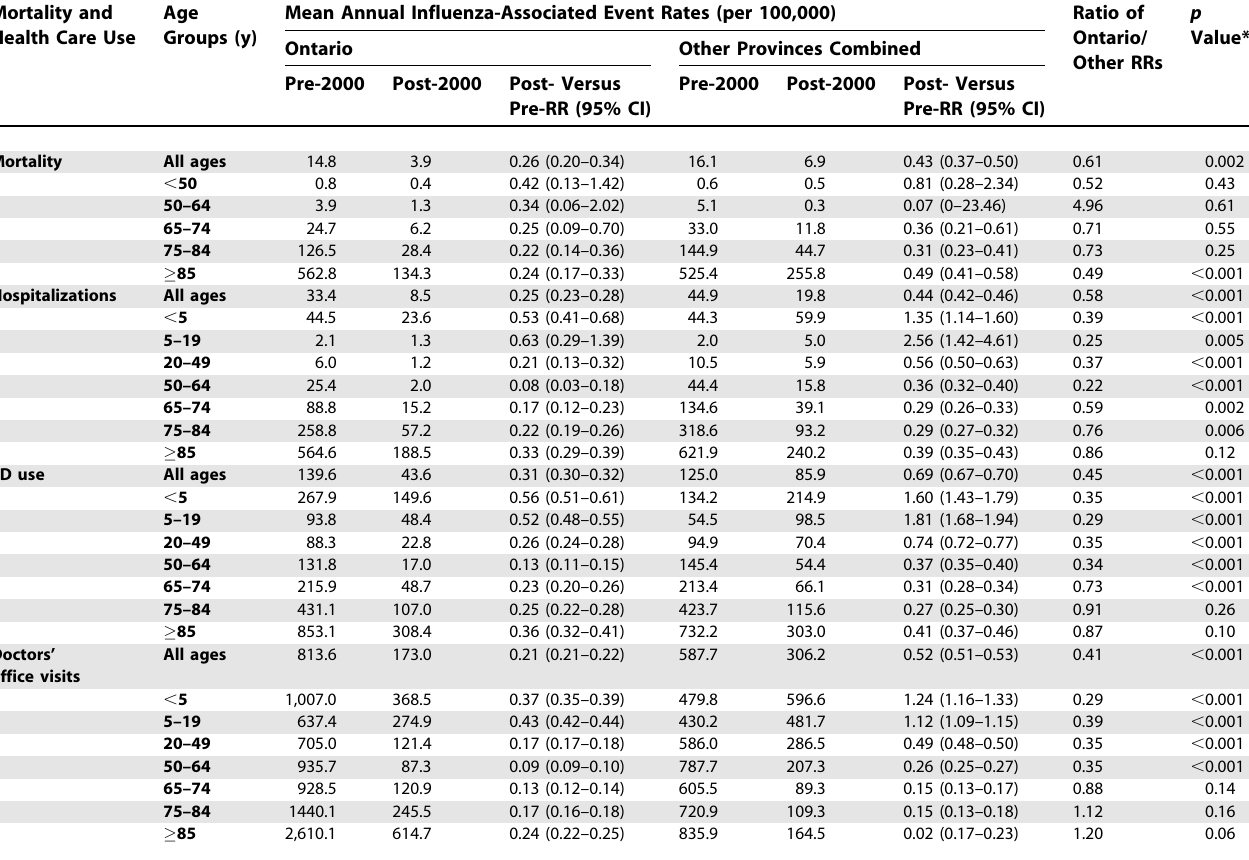
Table 3. Effect of UIIP on Influenza-Associated Mortality and Health Care Use Rates Mortality and Age Health Care Use Groups